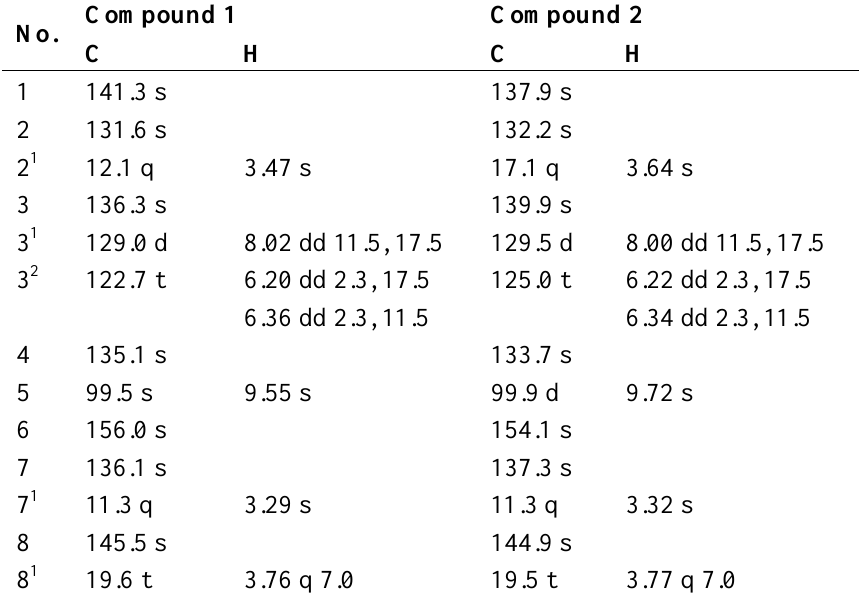
Table 1 . 1 H- and 13 C-NMR data of compounds 1 and 2 ( 500/125 MHz, respectively, in CDCl ; δ in ppm, J in 3